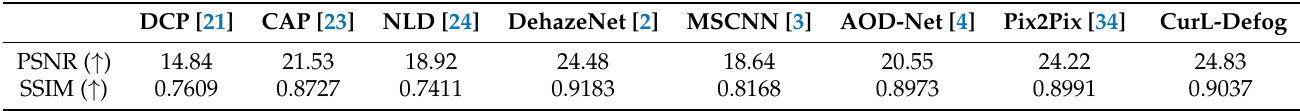
Table 4. Average SSIM and PSNR scores of the dehazing on the HSTS testing set (synthetic images). ↑ indicates that a higher value is